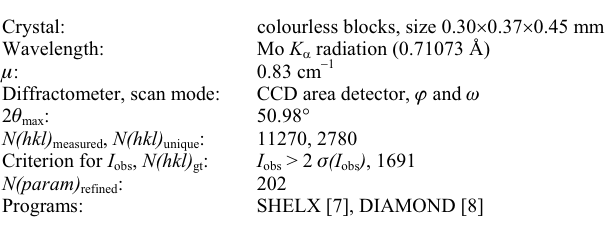
Table 1. Data collection and